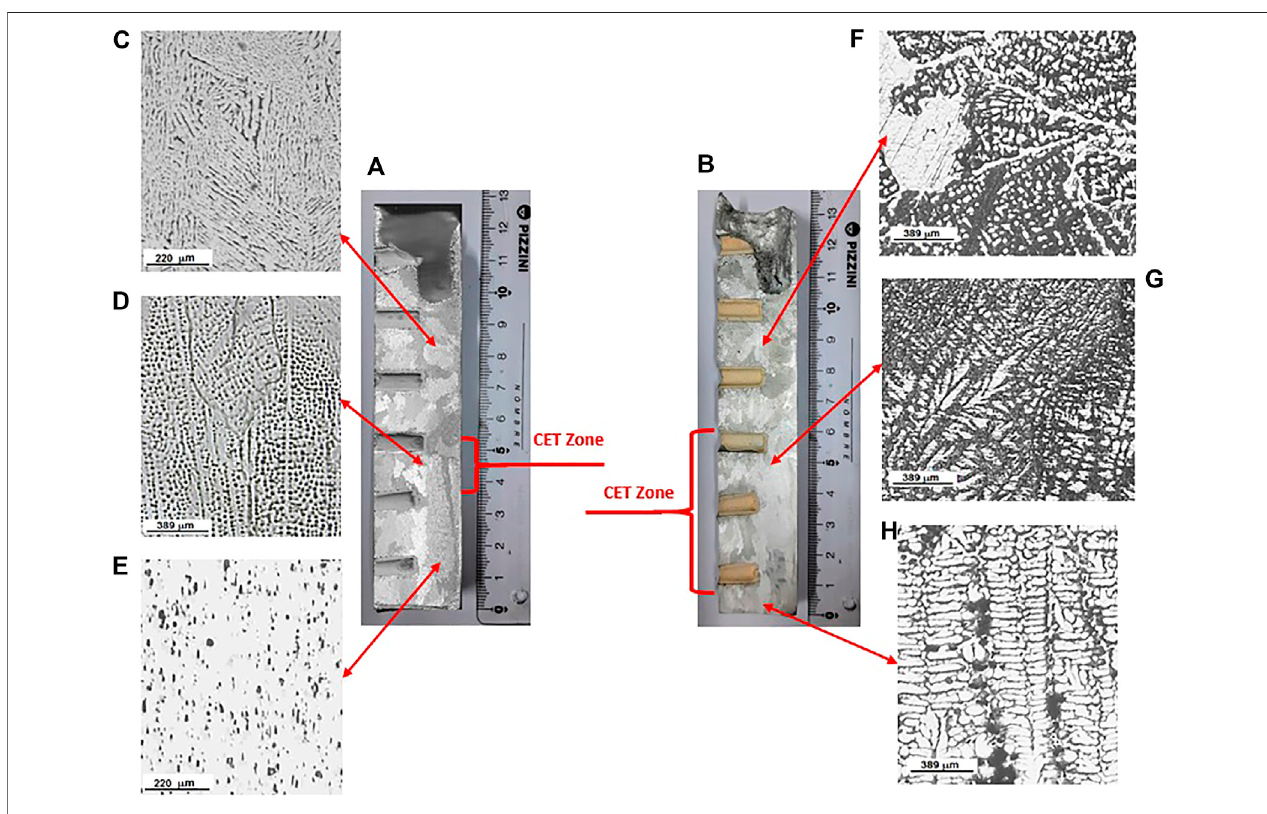
FIGURE 2 | Macrostructures: (A) Al-0.5wt.%Mg. (B) Al-2wt.%Mg. Microstructures: (C – E) Al 0.5wt.%Mg. (F – H) to (h) Al-2wt.%Mg.